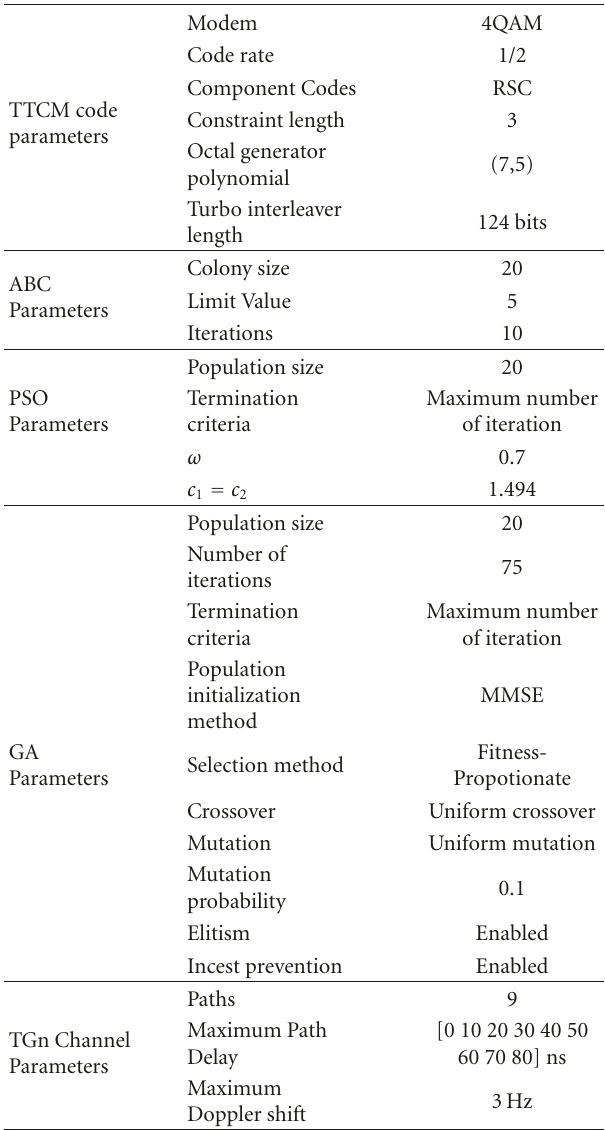
Table 1: Basic simulation